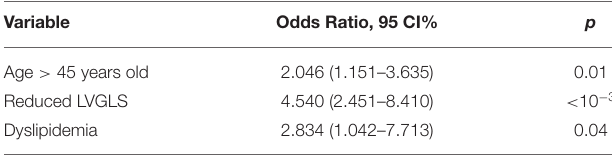
TABLE 5 | Associated factors to endothelial dysfunction in multivariate